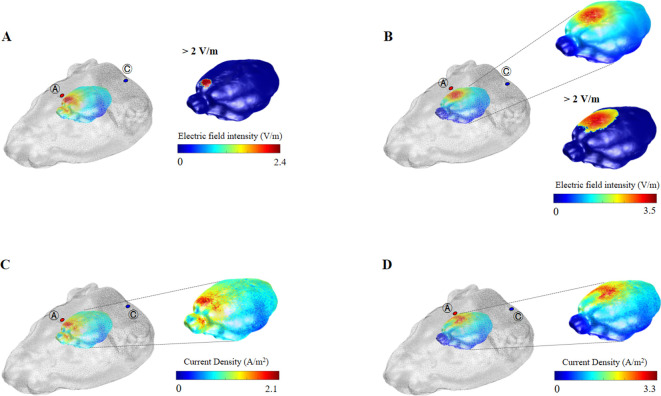
Three-dimensional tDCS simulation over the prefrontal and primary motor cortex.(A, C) Three-dimensional tDCS simulation over the prefrontal cortex. (B, D) Three-dimensional tDCS simulation over the primary motor cortex. The highest electric field intensity and current density values are represented in red, and the lowest electric field intensity and current density values are represented in blue. False color: electric field intensity (V/m) and current density (A/m2). Ⓐ, anode electrode; Ⓒ, reference electrode. The predicted peak current density was 2.1 A/m2 in the prefrontal cortex. The predicted peak electric field intensity and current density over the primary motor cortex were 3.5 V/m and 3.3 A/m2, respectively. The label ‘>2 V/m’ shows the areas where the electric field is thresholded above 2 V/m, which are localized to the prefrontal and primary motor cortex.